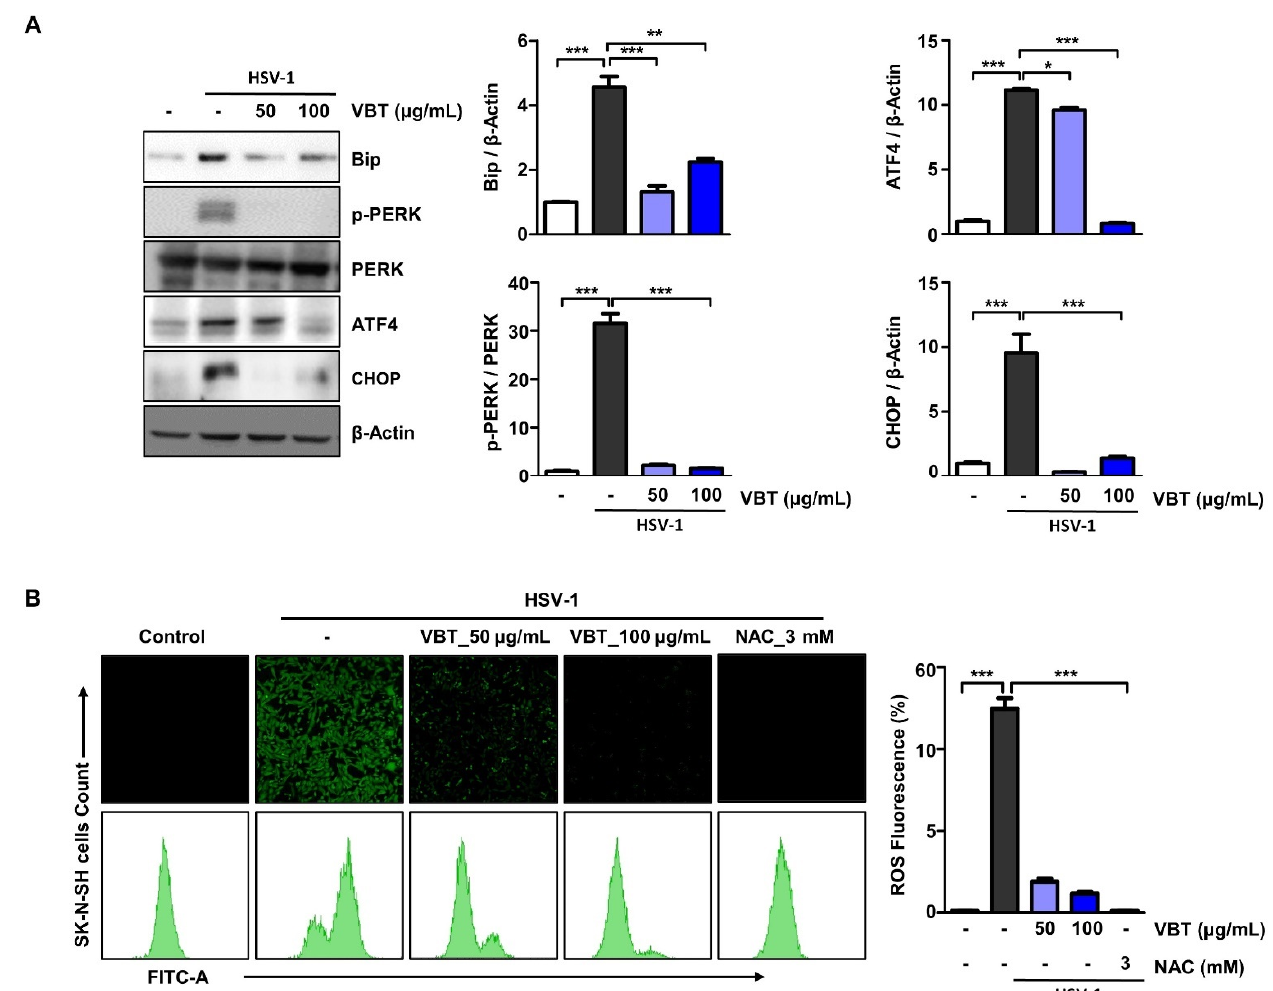
Figure 5. Inhibition of ER Stress and ROS by HSV-1 induction of VBT in SK-N-SH Cells. ( A ) Cells were infected with HSV-1 (MOI = 0.1) for 2 h and then replaced with fresh medium. Then, they were treated with VBT (50 μ g/mL and 100 μ g/mL) and ACV (10 μ g/mL), and incubated for 48 h. ER stress-related factor proteins were identified by Western blotting. The expression of these proteins was normalized to that of β -Actin as a relative ratio. ( B ) Cells were infected with HSV-1 at MOI = 0.1 concentration for 2 h, then VBT (50 μ g/mL and 100 μ g/mL), and cultured for 24 h, followed by ROS analysis. NAC was used as a positive control. The level of ROS was measured using fluorescence microscopy and FACS. * p < 0.5, ** p < 0.01, *** p < 0.001 vs. HSV-1 treatment cells.